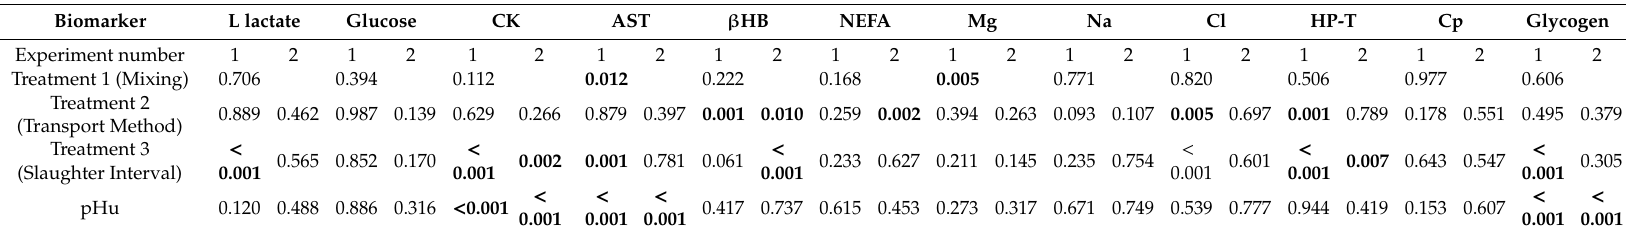
Table 7. p values for the e ff ects of mixing, transport, slaughter interval and pHu on plasma and muscle metabolites concentration. Bold represents p <